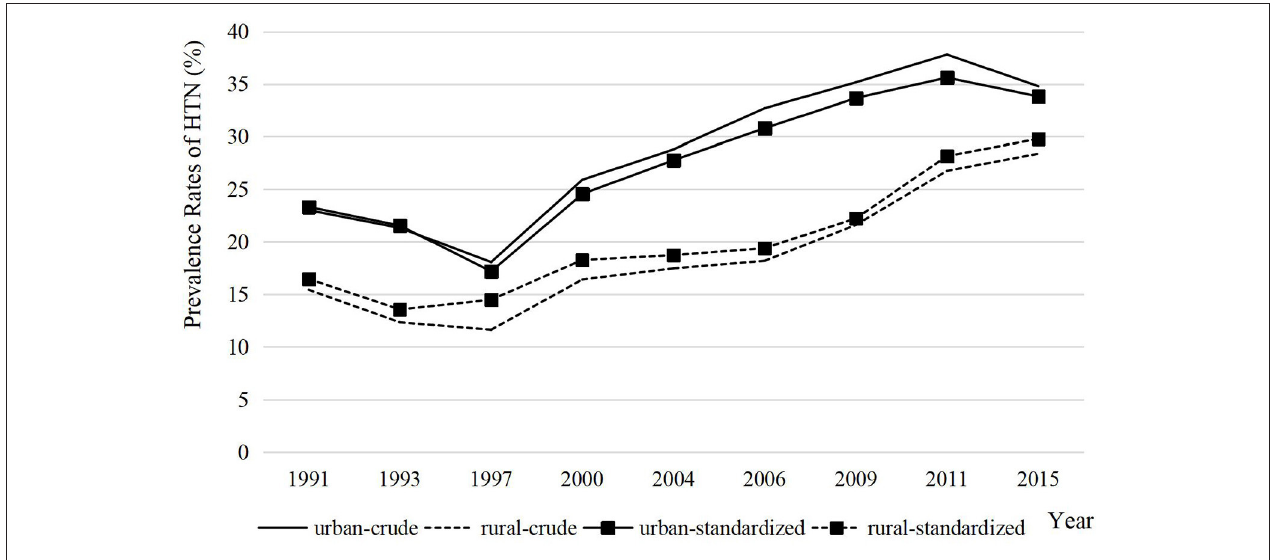
FIGURE 1 | Crude and standardized prevalence rates of HTN in older adults in urban and rural areas,